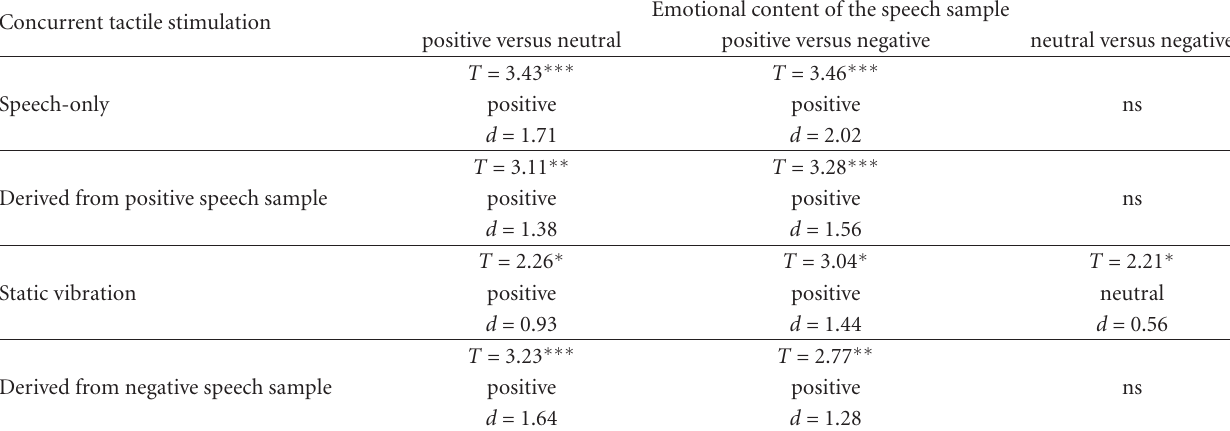
Table 6: Pairwise comparisons between the speech samples within the four concurrent tactile stimulation categories. Concurrent tactile